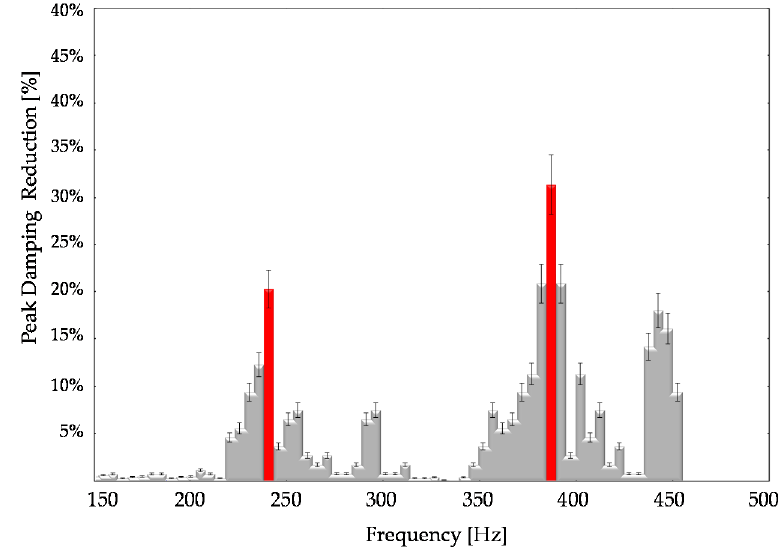
Figure 11. Residual vibration peak reduction percentage on X axis. Table 5. Experimental real time effectiveness.